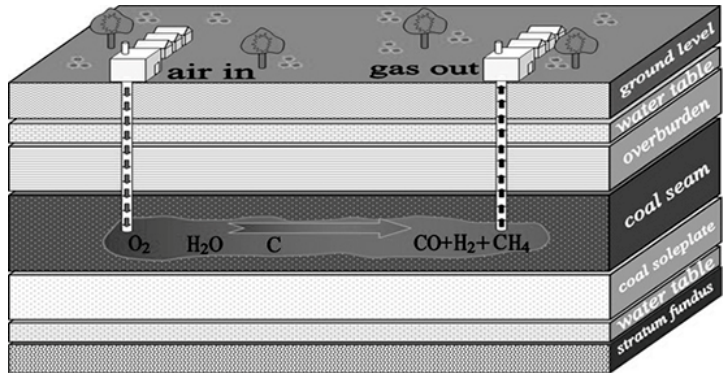
Figure 1. Sketch of the underground coal gasification (UCG) process.